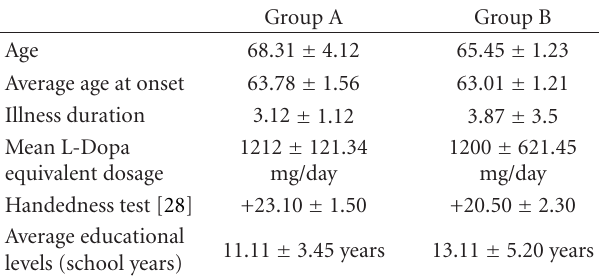
Table 2: Synopsis of the baseline characteristics of the two